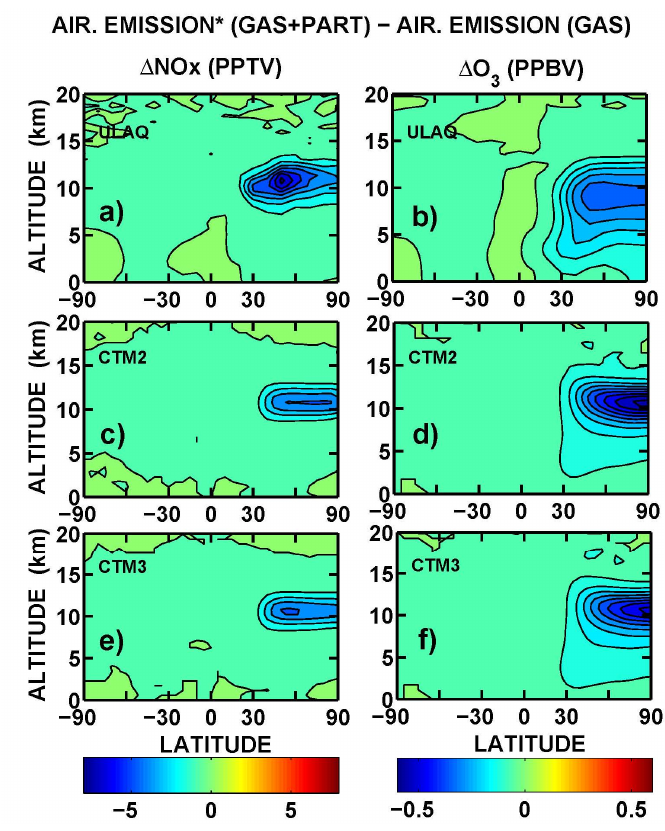
Figure 9. Zonally and annually averaged changes produced by aircraft aerosol emissions (AE*-AE) of NO x (left panels (a , c , e) ) and O 3 (right panels (b , d , f) ), for ULAQ, CTM2 and CTM3 models, from upper to lower panels, respectively. Black contours are shown every 2.5 pptv for NO x , and 0.05 ppbv for O 3